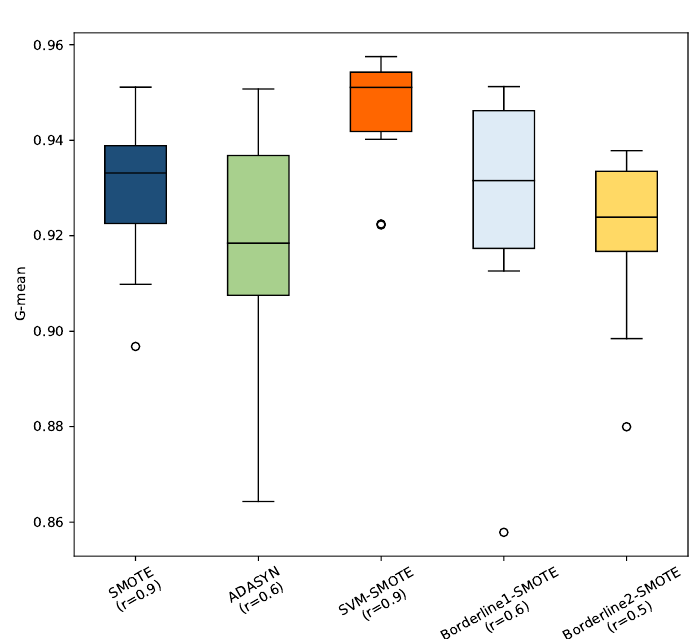
Figure 9. The box plot for the GM value for different oversampling techniques.